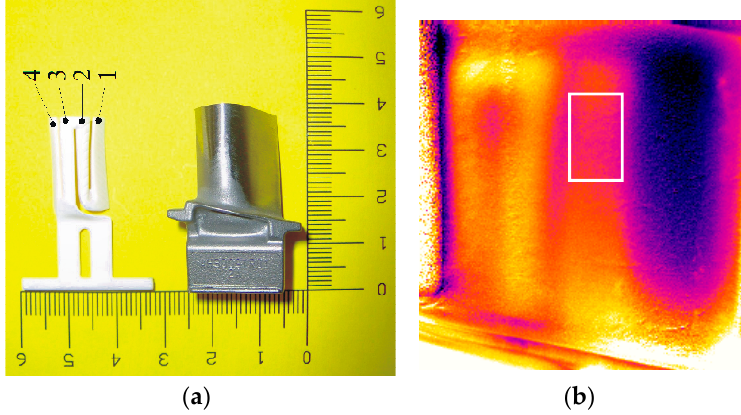
Figure 12. Phase image taken with SC3000 camera showing obstruction of a cooling passage in a turbine blade. ( a ) visible image; ( b ) phase image.